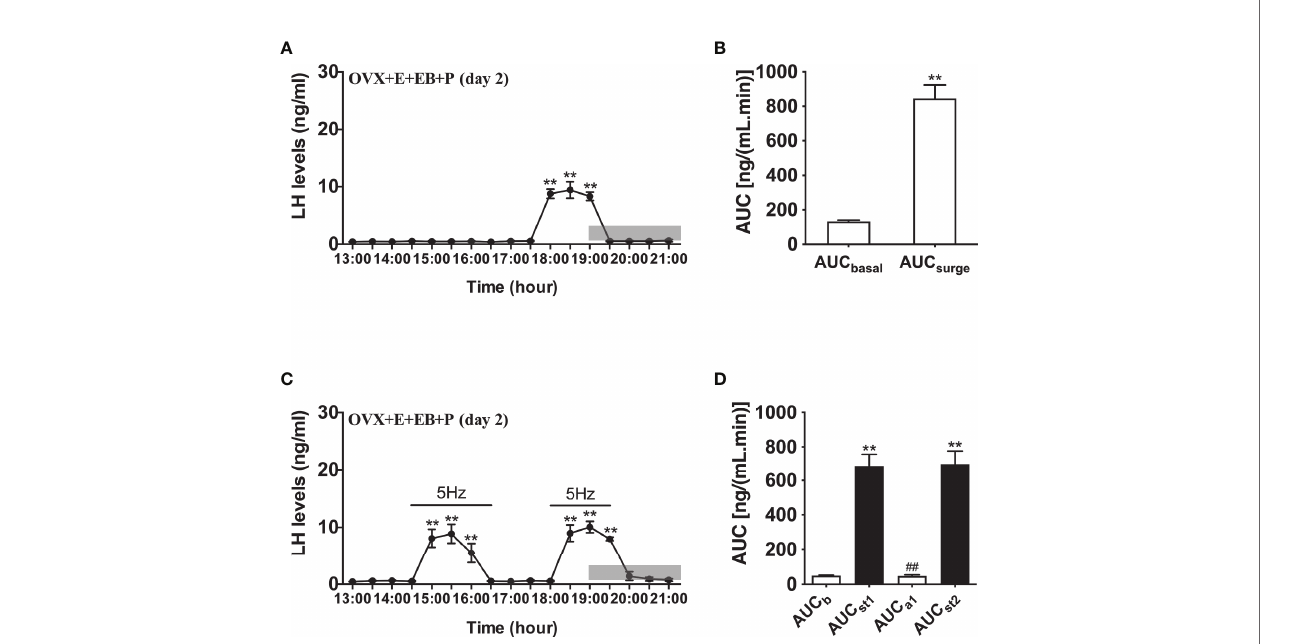
FIGURE 6 | Effects of optogenetic activation of ARC kisspeptin neurons on LH secretion in OVX estradiol capsule implanted Kiss-cre mice injected with estradiol benzoate and subsequently progesterone. (A) Mean circulating levels of LH (mean ± SEM) without optic stimulations of ARC kisspeptin neurons in OVX Kiss-cre implanted with estradiol capsules (E) and injected with estradiol benzoate (EB) and the following day injected with progesterone (P) as an LH surge inducing protocol (OVX+E+EB+P) (n = 4). Note the expected steroid induced LH surge at 17:30 h. (B) Area under curve of LH levels for basal (AUC b , 13:00 - 17:30 h) and surge (AUC surge , 17:30 - 19:30 h) time periods. (C) Evoked LH secretion in response to 5 Hz optic stimulations of ARC kisspeptin neuron (14:30 - 16:30 h and 18:00 - 19:30 h) in Kiss-cre OVX+E+EB+P mice (n = 5). (D) Area under curve of LH levels before early stimulation (basal) (AUC b , 13:00 - 14:30 h), during fi rst stimulation (AUC st1 , 14:30 - 16:30 h), after fi rst stimulation (AUC a1 , 16:30 - 18:00 h), and during second stimulation (AUC st2 , 18:00 - 19:30 h). The values are presented as mean ± SEM. **P < 0.01 (unpaired t-test) relative to basal LH levels or AUC for basal LH levels. ## P < 0.01 indicates a signi fi cant difference relative to AUC for LH levels during the fi rst and second stimulation periods. Lights off is at 19:00 h for all experiments, as indicated by the grey bar on the